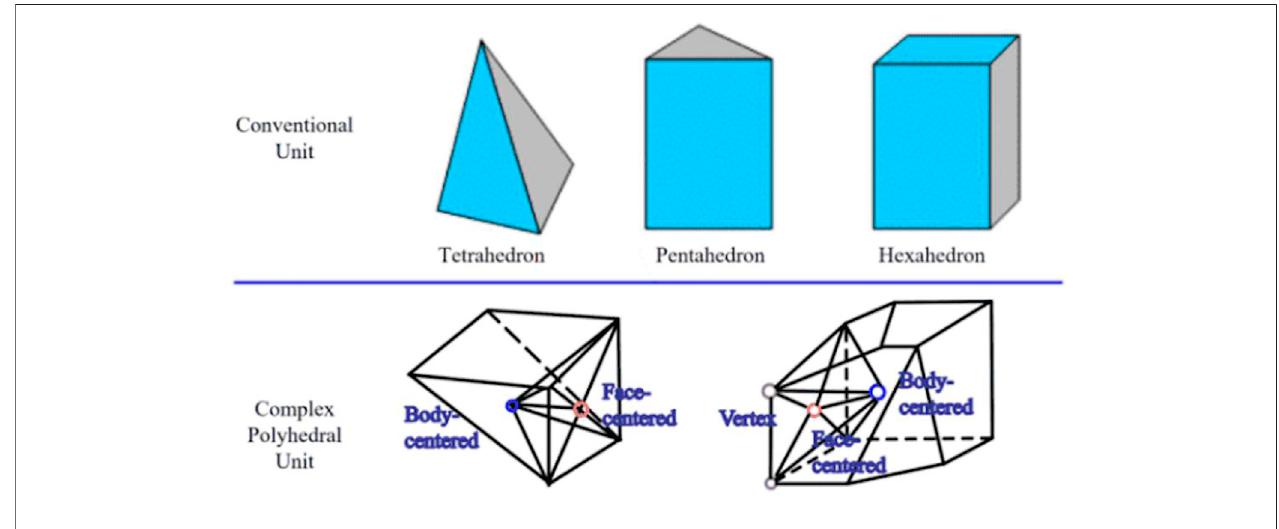
FIGURE 3 | Finite element unit in CDEM.